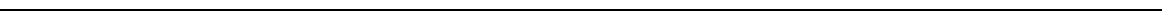
Fig. 3 Rescue experiment of the phenotype of il-11 KD tadpoles. a Schematic drawing of a rescue construct. Yellow boxes represent cis-regulatory elements, and green boxes represent coding sequences. gRNA #1U.LS target site was inserted in the construct. In the control construct, acgfp was inserted instead of il-11-p2a peptide-acgfp . b Schematic drawing of knock-in and knockdown. Bars : introns, orange boxes : untranslated regions, blue boxes : coding sequences, dark grey arrows : gRNA target sequences. c Schematic drawing of a rescue experiment. d – j Representative images of tails of control cas9 mRNA-injected d , e , il- 11 knockeddown acgfp -expressing f , g , or il-11 knockeddown il-11 – expressing h , i tadpoles, and their regeneration length j are shown. k , Schematic drawing of a rescue experiment using tadpoles treated with or without doxycycline. l-x Representative images of tails of untreated cas9 mRNA-injected l , m , il-11 knockeddown acgfp -expressing n , o , or il-11 knockeddown il-11 – expressing p , q tadpoles, or doxycycline-treated cas9 mRNA-injected r , s , il-11 knockeddown acgfp -expressing t , u , or il-11 knockeddown il-11 – expressing v , w tadpoles and their regeneration length x are shown. Dark- fi eld images d , f , h , l , n , p , r , t , v and GFP2- fi ltered images e , g , i , m , o , q , s , u , w are shown. Regeneration length was normalised by snout to vent length (SVL). Box plots are inserted in the panels. Bars in the boxes represent median, upper and lower limits of the boxes represent the fi rst and third quartiles, and whiskers represent maximum and minimum values. Scale bars : 1 mm. Anterior is to the left , dorsal is up . Yellow broken lines indicate outline of the tails. White broken lines indicate amputated plane. * P < 0.05, Tukey − Kramer ’ s